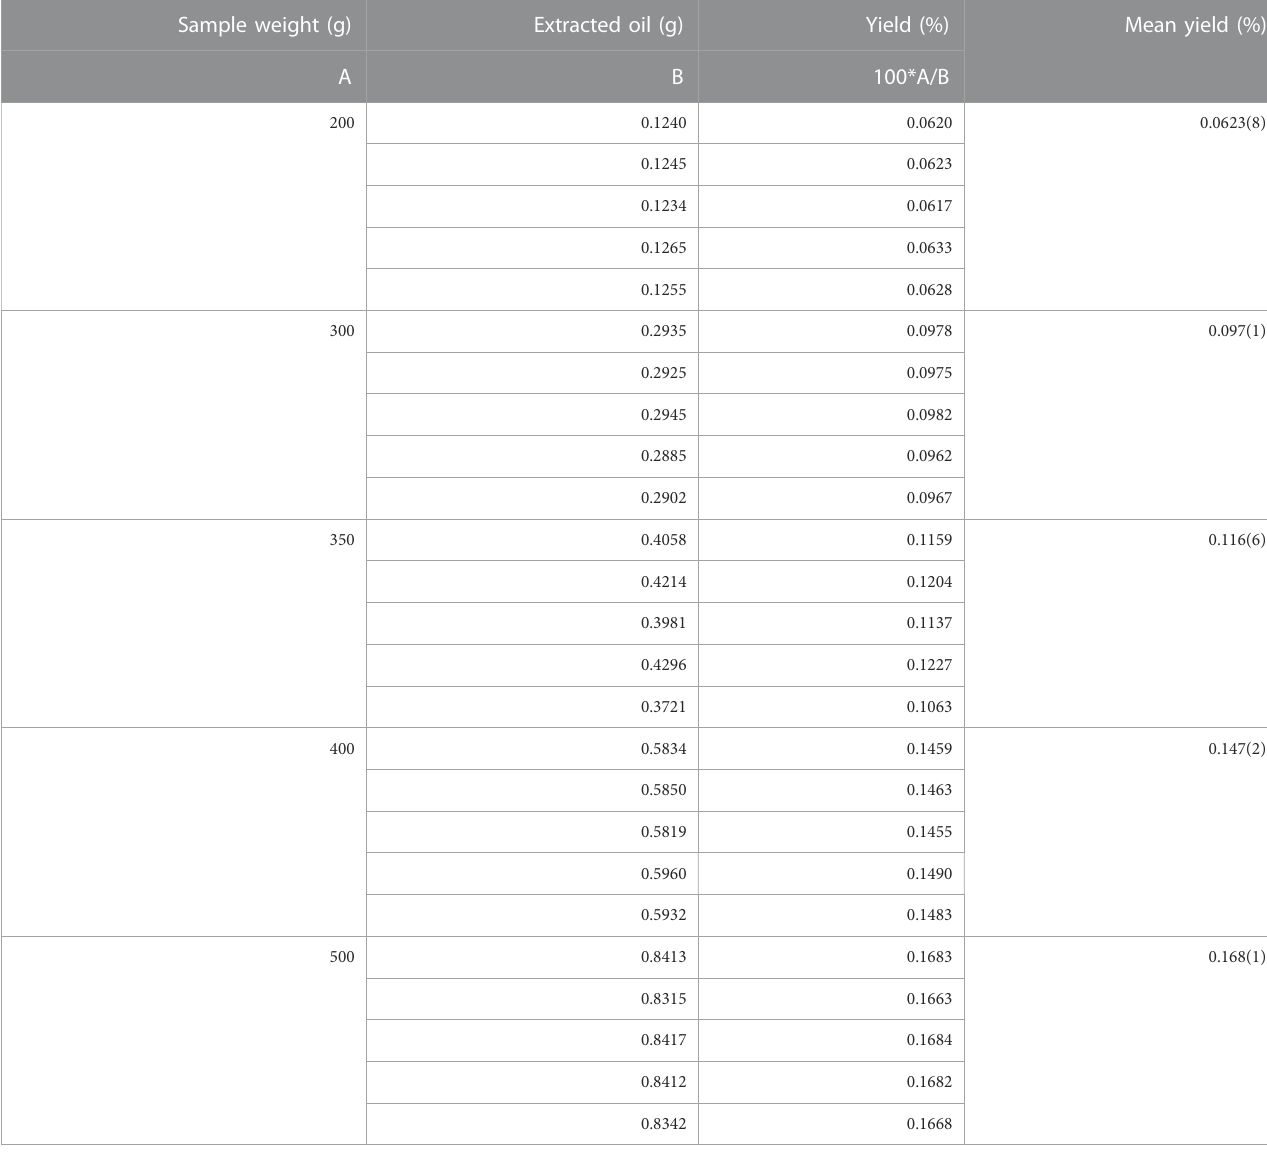
TABLE2Extractionyield of eachmassloading with fi verepetitionsperset.Values inparenthesisarepartof thet-distributioncon fi denceinterval atthelast signi fi cant fi